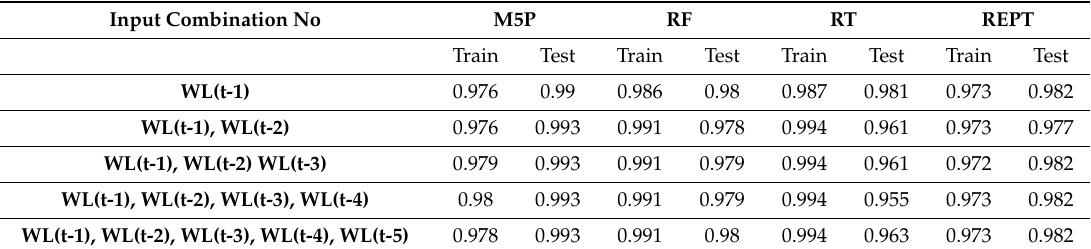
Table 4. Best model input combinations during the training and test phases based on the correlation coe ffi